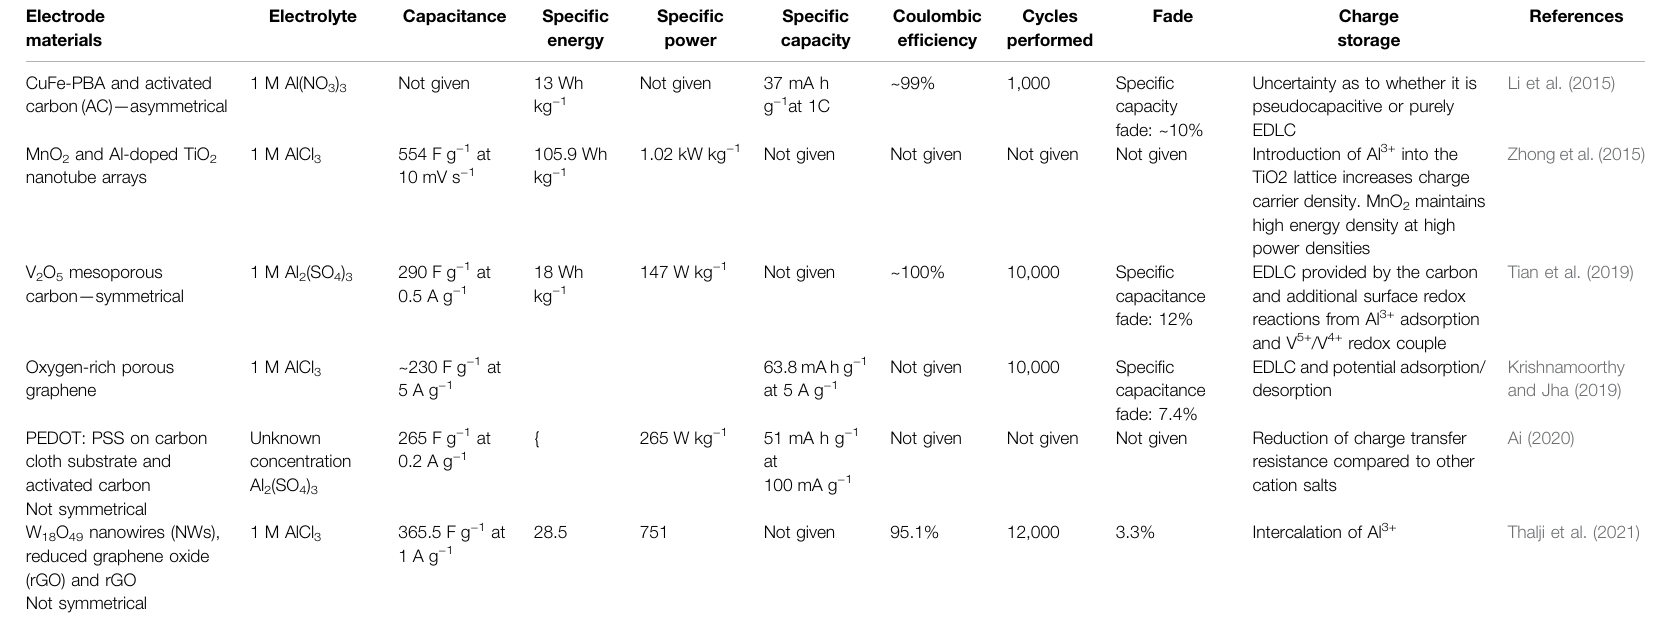
TABLE 2 | Summary of recent Al-ion